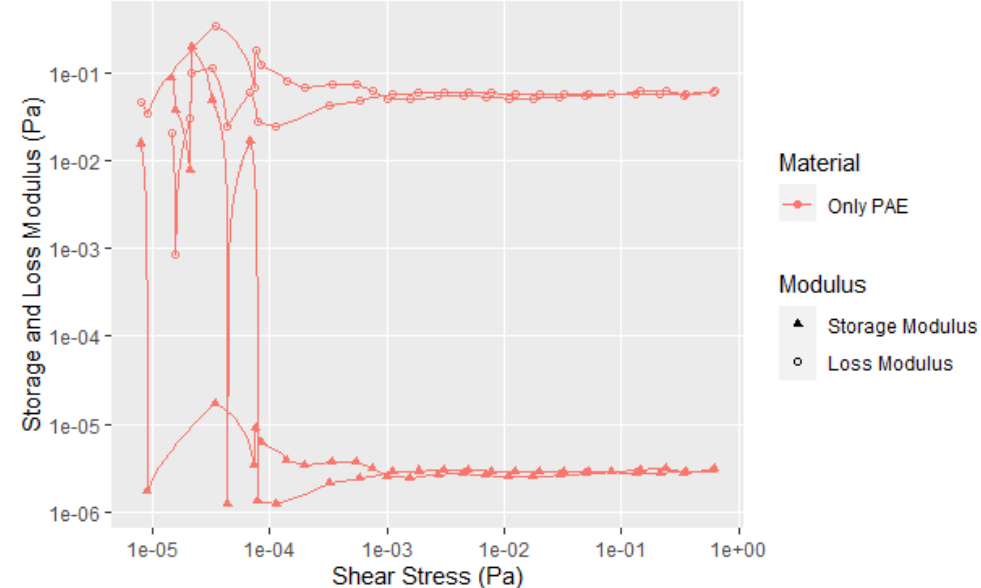
Figure 14. Shear curves for solutions of PAE at the same concentration as the “5% PAE” mixtures shown in Figures 12 and 13 and with pH adjusted to pH 7. For consistency, the PAE was run under the same conditions, even though the first few data points are at the machine limits of consistent measurements.